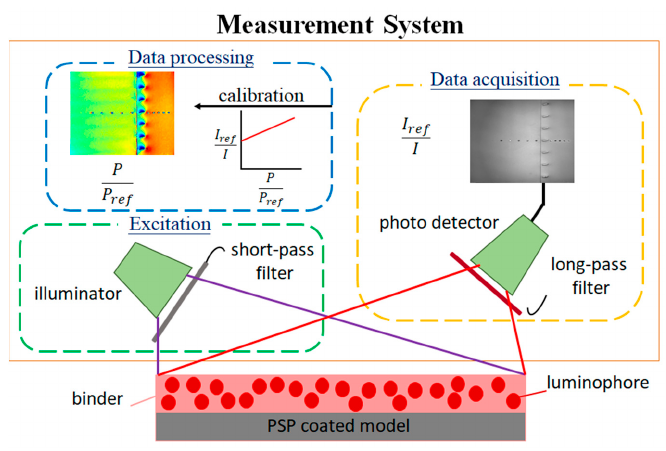
Figure 5. PSP measurement system.